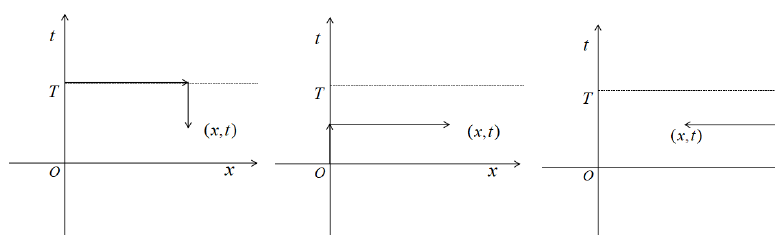
Figure 1. Integral